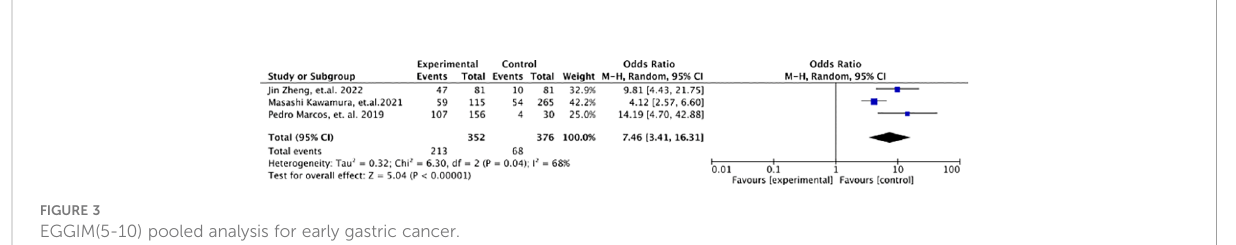
FIGURE 3 EGGIM(5-10) pooled analysis for early gastric